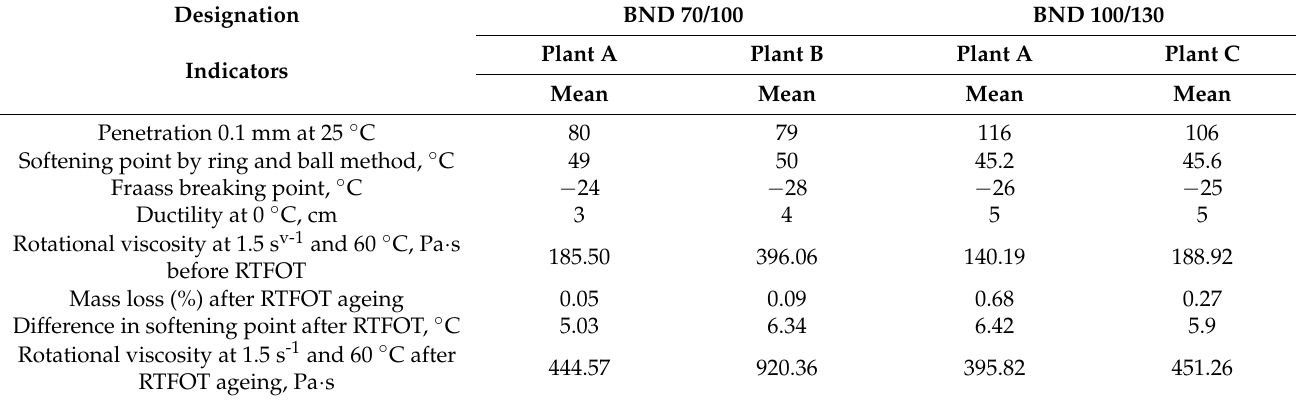
Table 13. Summarising the mean physicochemical properties of the bituminous binders